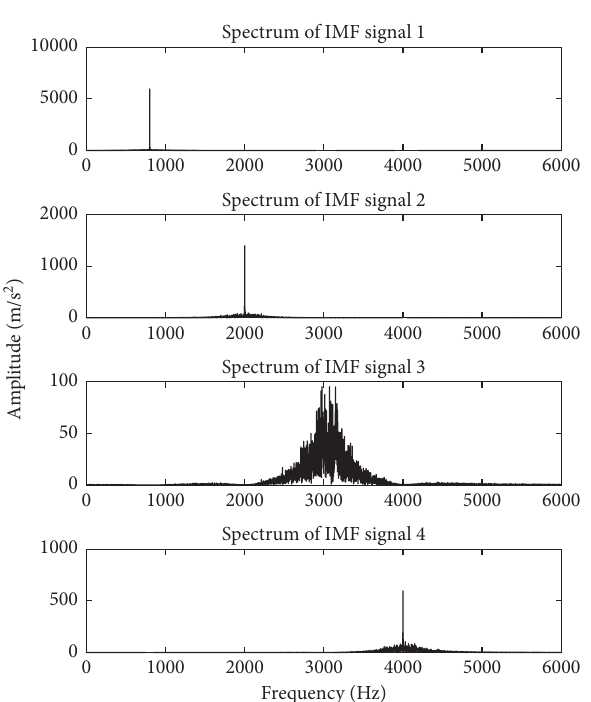
Figure 4: IMF spectrograms decomposed with the VMD.